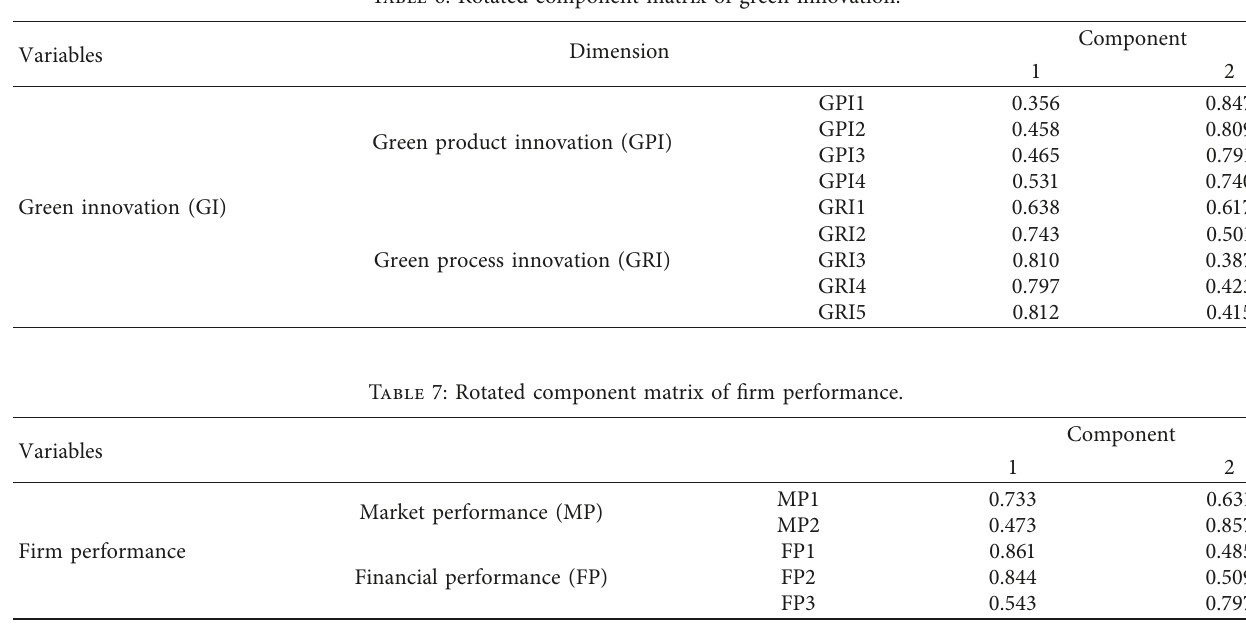
Table 6: Rotated component matrix of green innovation.